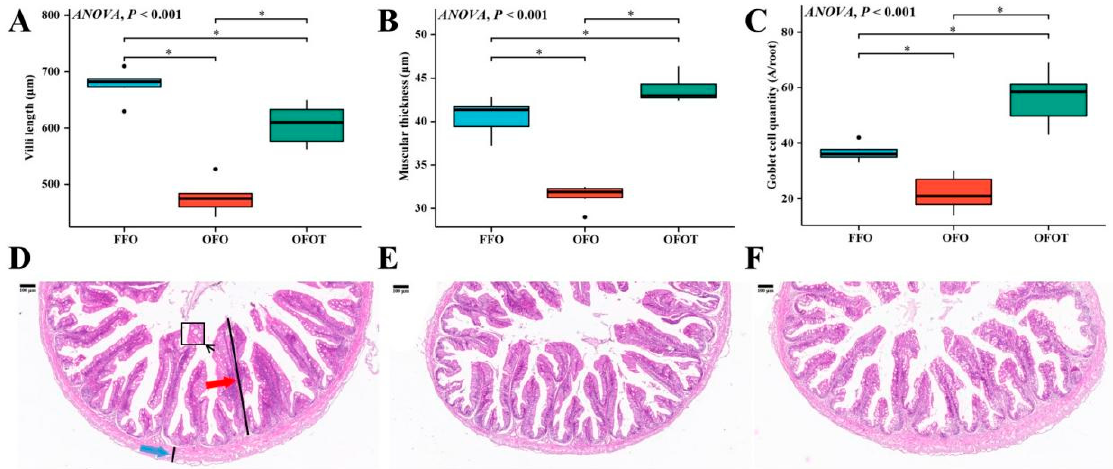
Figure 5. Effects of dietary taurine on intestinal morphology of channel catfish ( Ictalurus punctatus ) fed oxidized-fish-oil diets (magnification 40 × ). ( A ) Villi length; ( B ) muscular thickness; ( C ) goblet cell quantity; ( D ) FFO group; ( E ) OFO group; and ( F ) OFOT group. The red arrow indicates the villi length and the blue arrow indicates the muscular thickness, respectively. Significance was evaluated by one-way ANOVA ( p < 0.05) followed by Duncan’s multiple range tests. * p < 0.05.